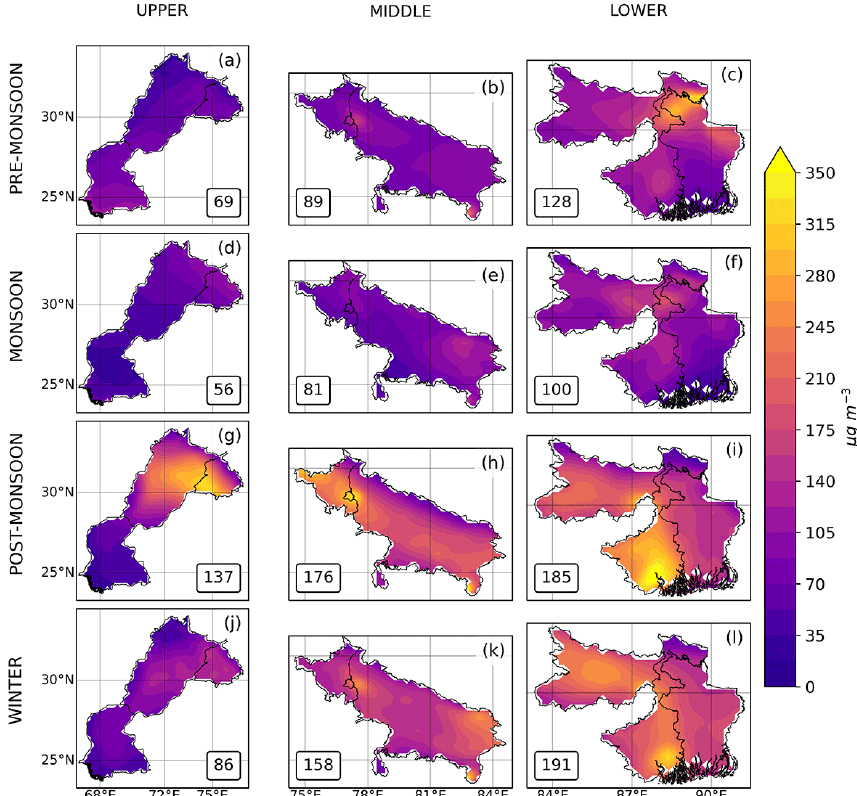
Figure 3. Seasonal mean spatial distributions of PM 2 . 5 (µgm − 3 ) over the upper, middle and lower IGP. The numbers inset denote the regional mean PM 2 . 5 values of pre-monsoon (a–c) , monsoon (d–f) , post-monsoon (g–i) , and winter (j–l)